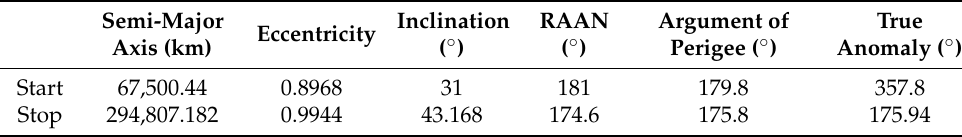
Table 5. Lunar trajectory Parameter